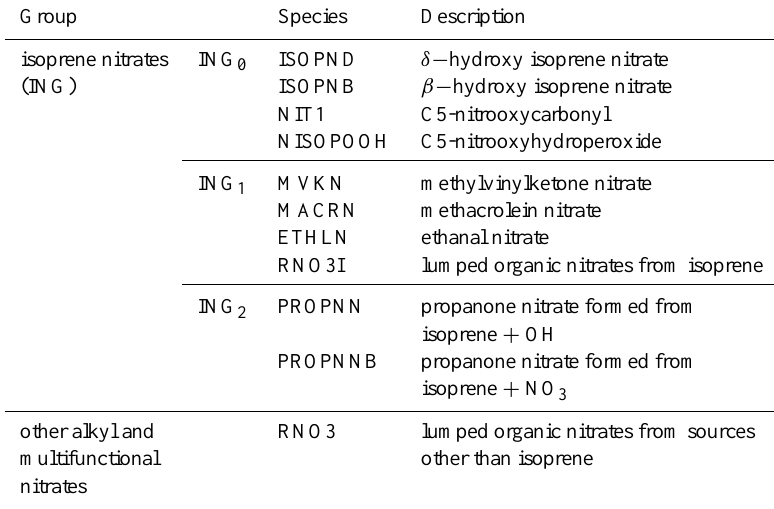
Table 1. Speciated alkyl and multifunctional nitrates in the IS